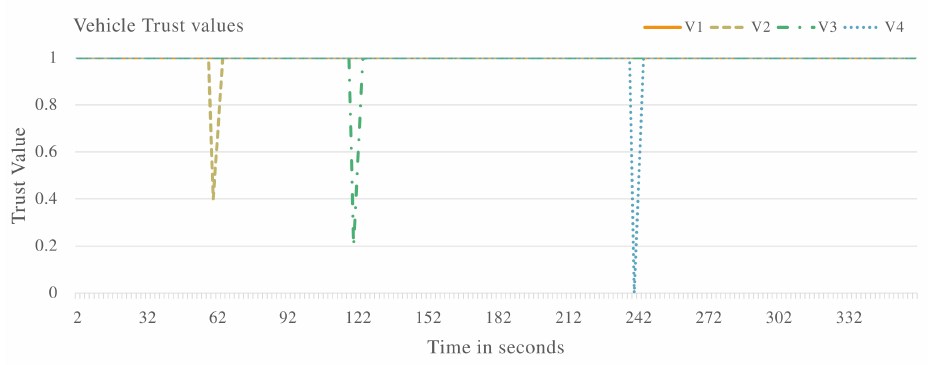
Figure 14. Vehicle trust value false positives.